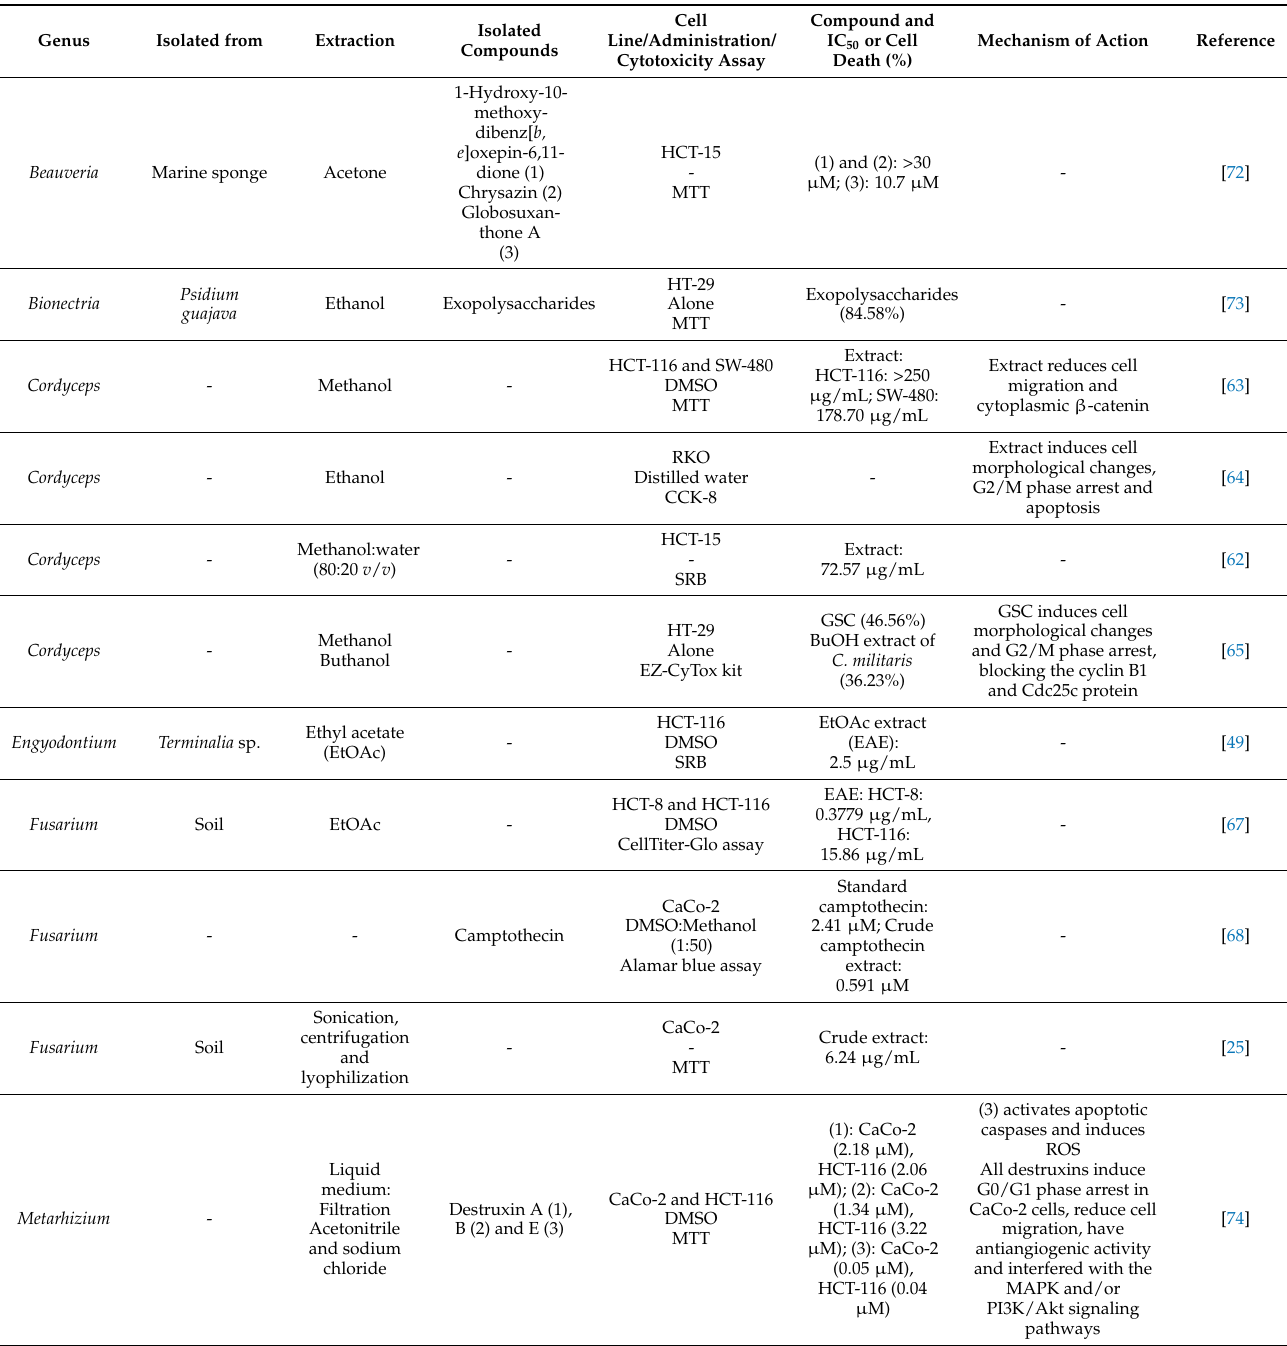
Table 2. Antitumor activity of the extracts or isolated compounds from Hypocreales order in CRC cancer cell